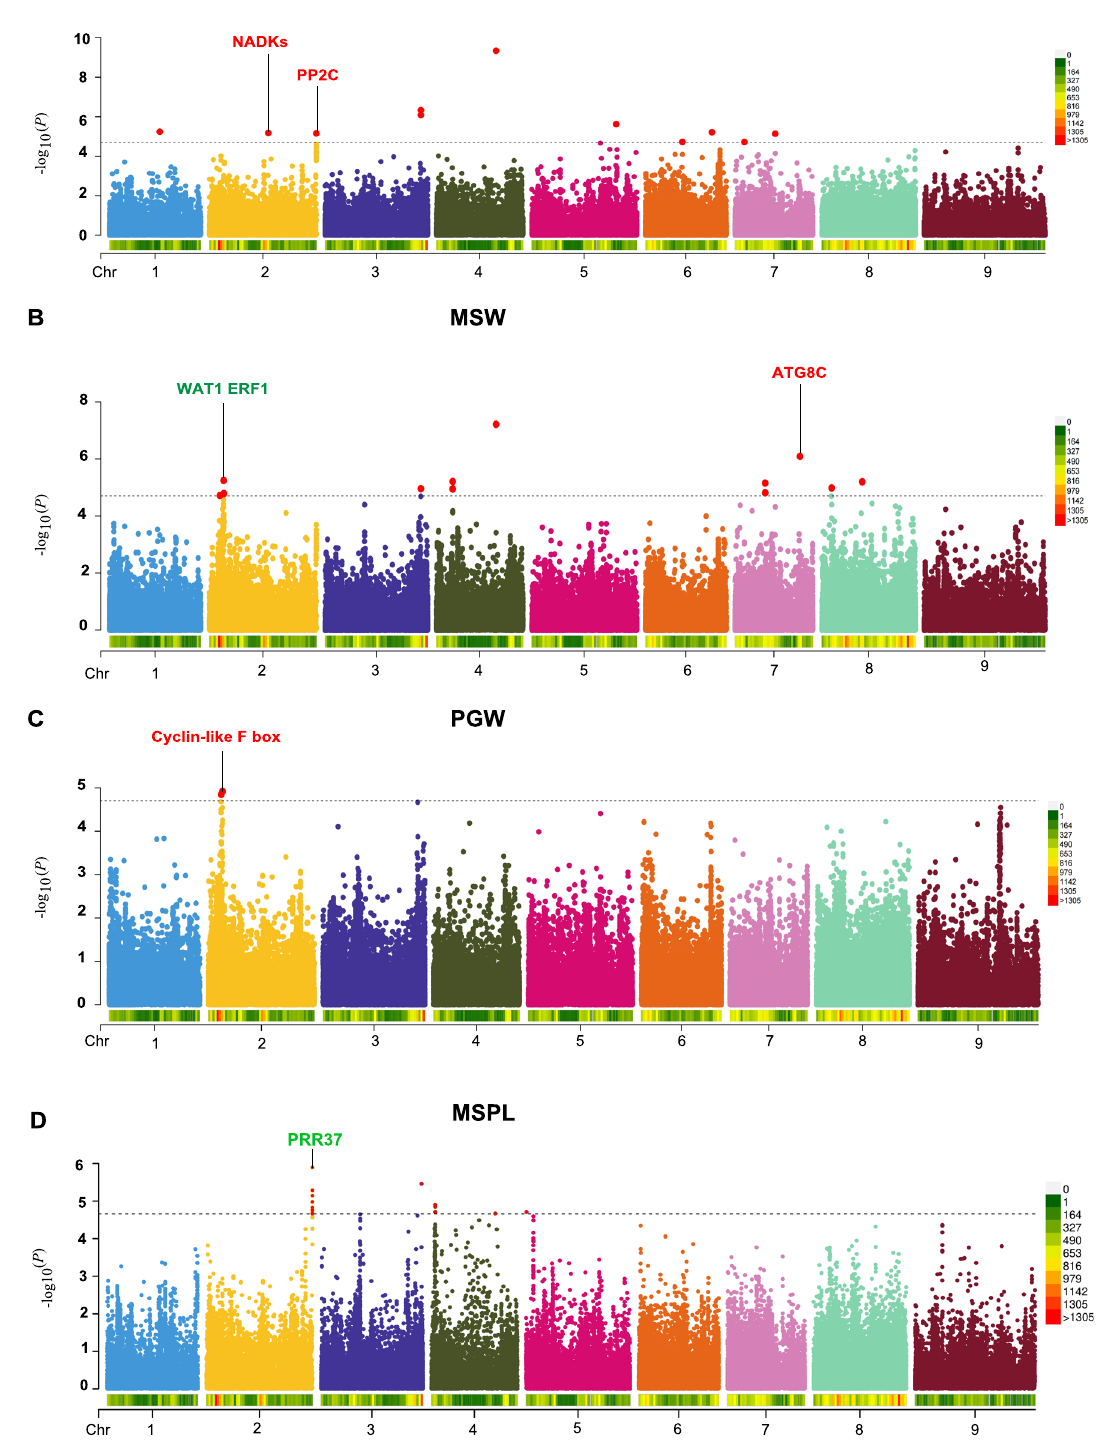
Fig.1|GWASofagronomictraitsinfoxtailmillet. Manhattan plots showing the genome-wide associations between host genetic SNPs and A panicle diameter of the main stem (MSPD), B main stem width (MSW), C per plant grain weight (PGW) and D panicle length of the main stem (MSPL). The dotted line cor- responds to a signi fi cance threshold of 2.01e − 5. Genes with signi fi cant SNPs